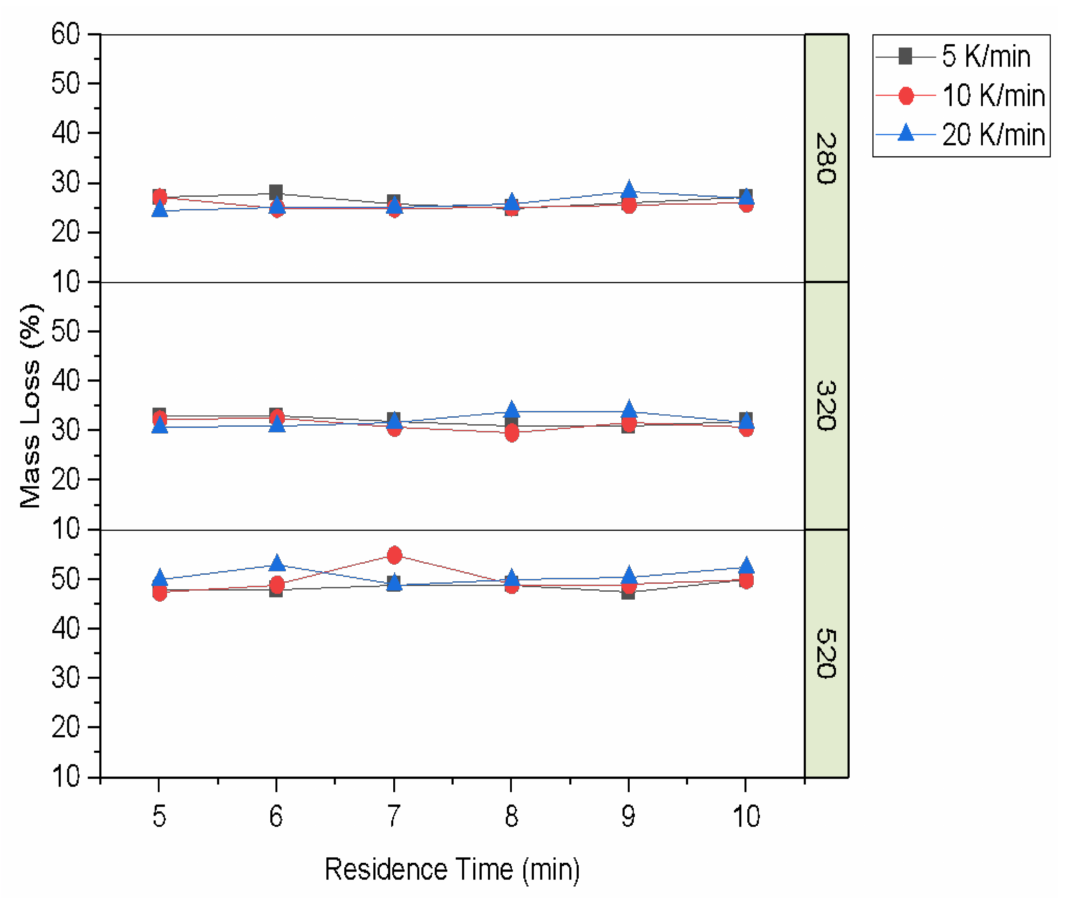
Figure 7. Mass losses during thermogravimetric analysis of sewage sludge at different temperatures. At the maximum temperature of 520 ◦ C, the mass loss was observed in a range of 47–50% with a heating rate of 5 K/min. Minimum and maximum mass losses were found to be 16 and 55% with respect to the lower and higher working temperatures at a 10 K/min rate. Average mass loss during the 10 K/min heating rate was found to be higher than 5 K/min. Minimum and maximum mass losses were found as 17 and 56% at 20 K/min heating rate. In the case of sewage sludge, the lowest weight loss was achieved during the process at a heating speed of 10 K/min, a residence time of 5 min, and a temperature of 280 ◦ C. Figure 8 indicates the sewage sludge mass loss during thermogravimetric analysis at every 10 ◦ C point in the scale 250–520 ◦